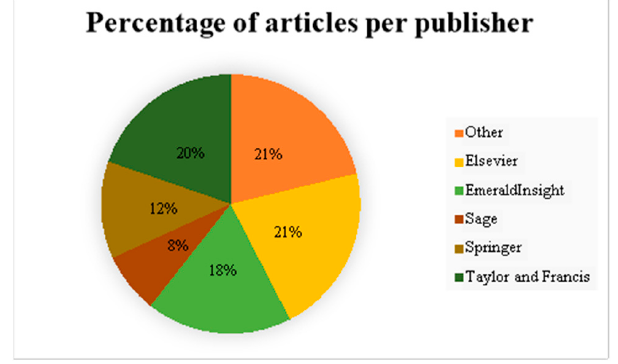
Figure 4. Percentage of articles per publisher.